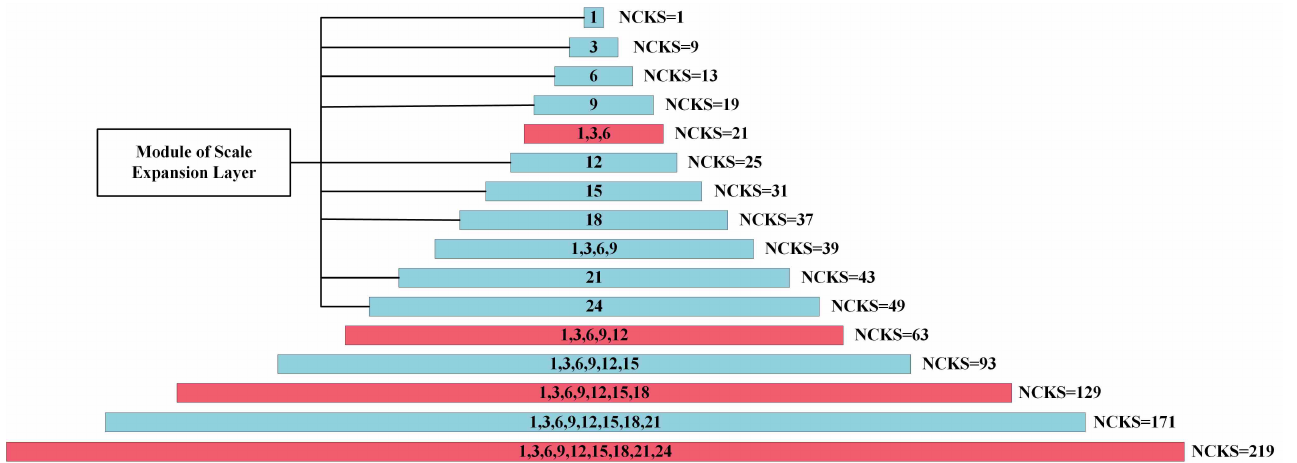
Figure 6. Pyramidal dense-scale expansion layer. The number in the pyramid structure is the expansion rate, and the scale expansion layer marked red will be added to the network